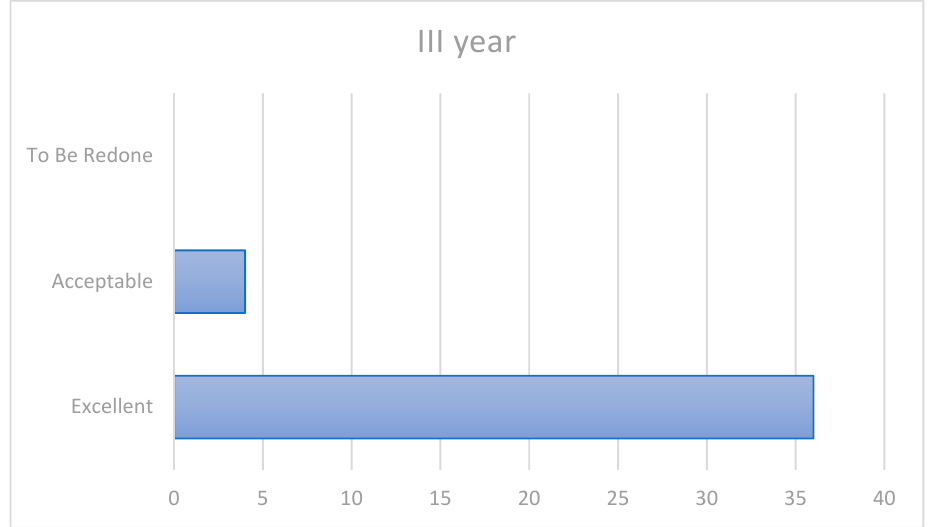
Figure 2. Third-year outcomes.